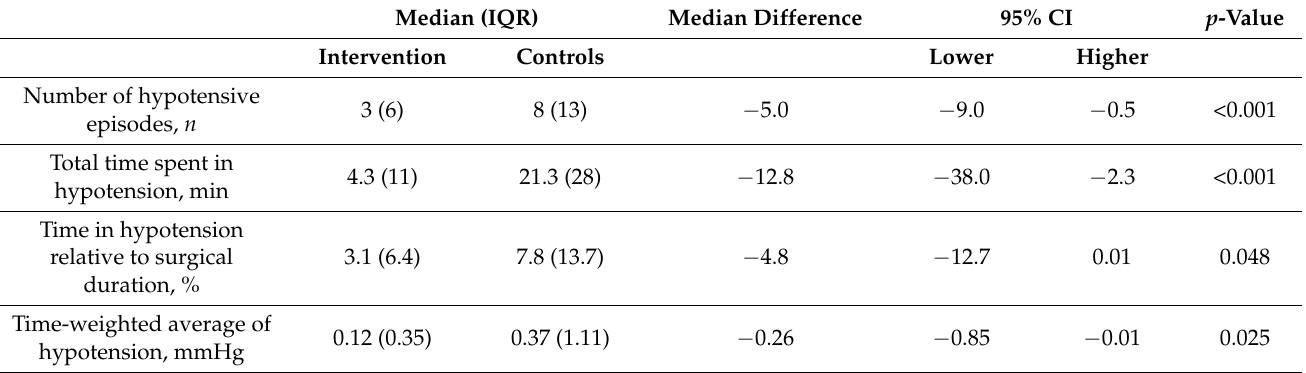
Table 2. Comparison of hypotension-related outcomes in the intervention and control